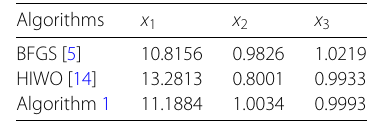
Table 3 Results of these algorithms